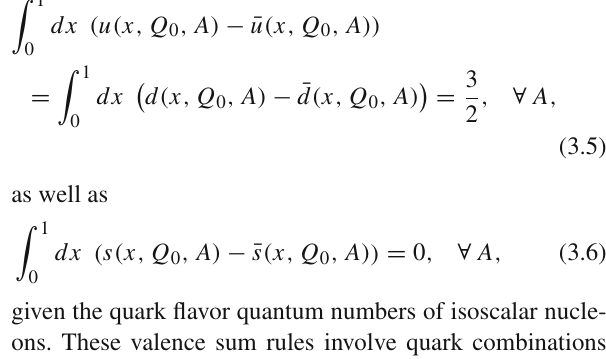
of the architecture of the feed-forward neural network used in the present analysis. The input layer contains three neurons which take as input the values of the momentum fraction x , ln ( 1 / x ) , and atomic mass number A , respectively. The subsequent hidden layer contains 25 neurons, which feed into the final output layer of three neurons, corresponding to the three fitted distributions (cid:12), T 8 and g . A sigmoid activation function is used for the neuron activation in the first two layers, while a linear activation is used for the output layer.